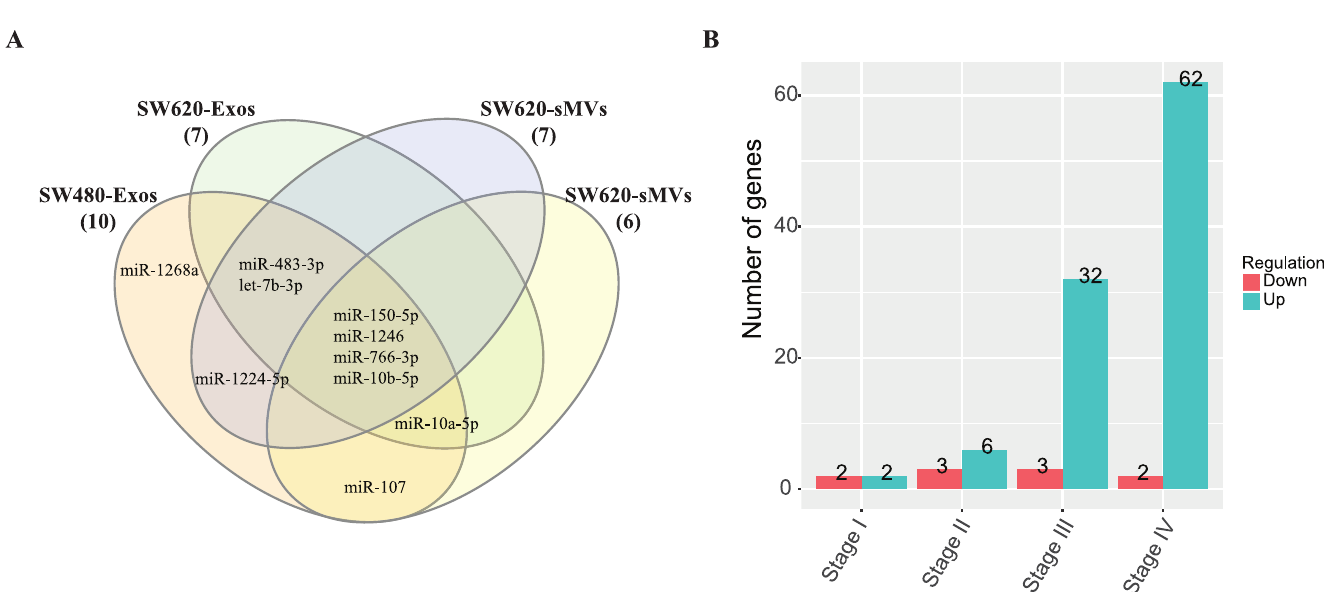
Fig 5. Comparison of miRNA profiles of SW480/SW620 EVs and circulating EVs. A. Venn diagram of miRNAs enriched in SW480/S620 EVs and miRNAs up- regulated in the serum EVs of CRC patients. B. Number of miRNAs enriched in SW480/SW620 EVs that are differentially expressed in the plasma EVs of different CRC stage